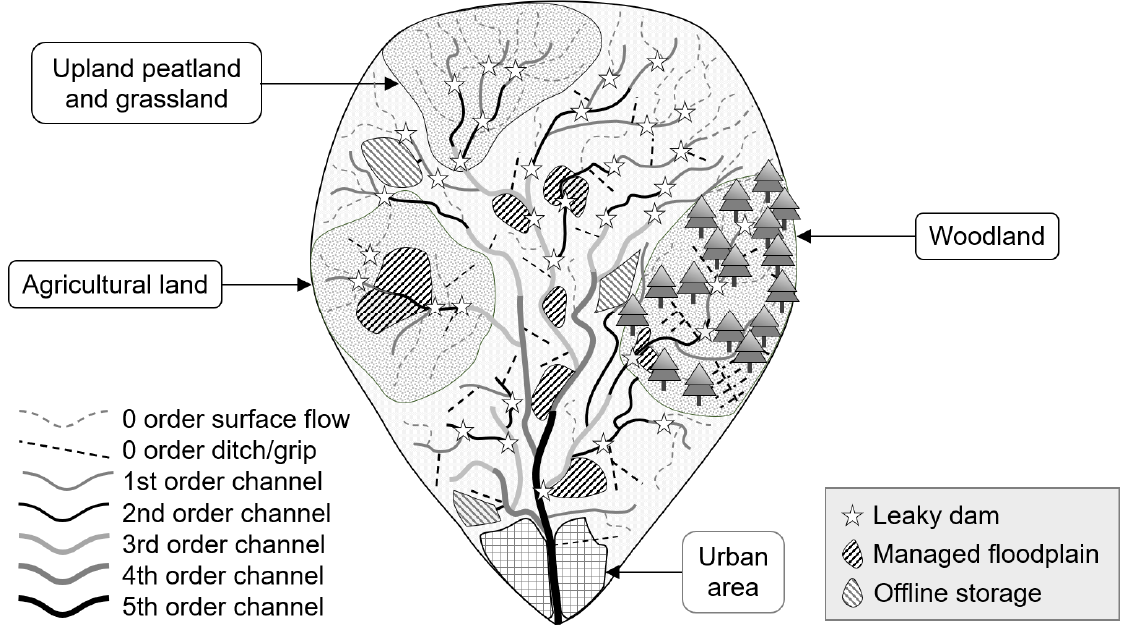
Figure 1. A Catchment Systems Engineering approach to water management adapted from Hewett et al. [19]. Here we assume the catchment is about 10–20 km 2 .